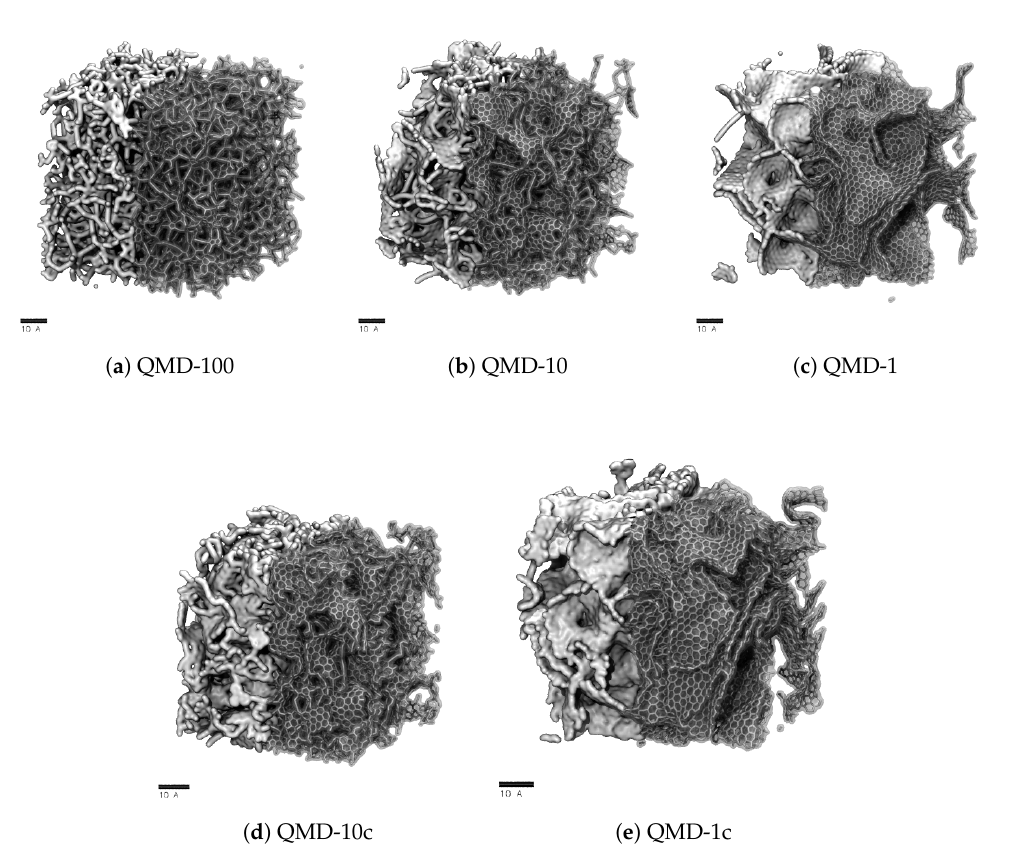
Figure 2. Sample structures produced via quenched molecular dynamics (QMD) at quench rates and comparison to STEM of Si-CDC from experiment. Simulation boxes are between 6.5 and 7.5 nm in length and include 20,000 atoms. Each scale bar is 10Å or 1nm